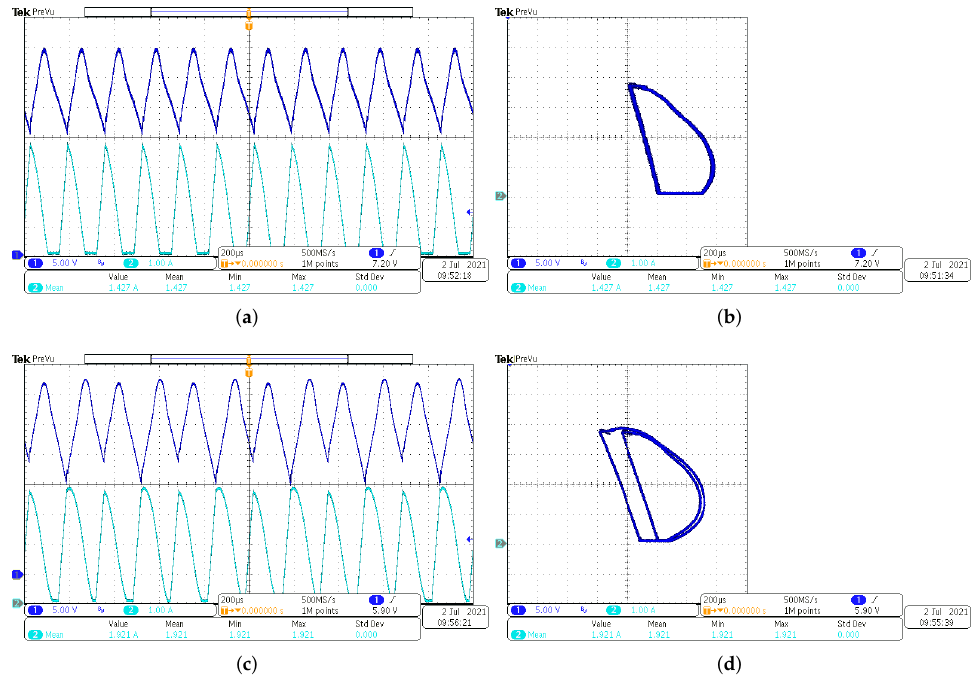
Figure 4. Waveforms of an open-loop boost converter operating in DCM loaded by an ideal CPL. ( a , b ) P = 28 W: stable periodic regime, ( c , d ) P = 30 W: subharmonic oscillation due to period- doubling